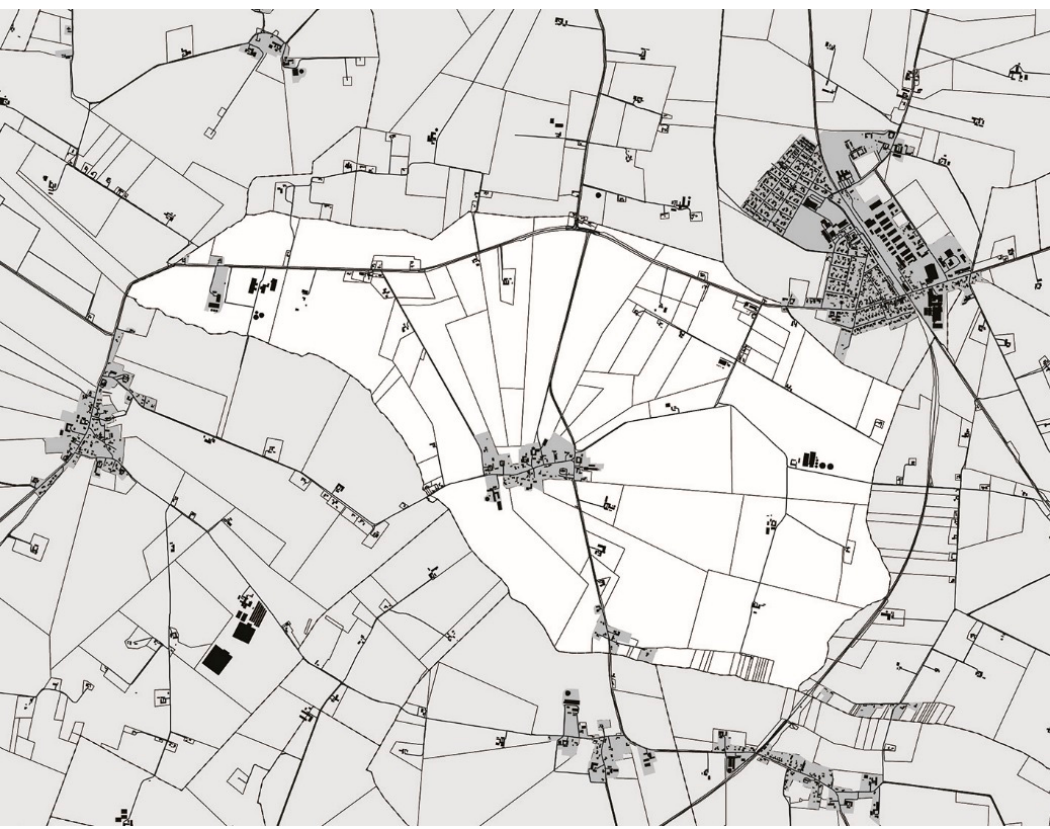
Figure 2. Map of Høve. The white area indicates the area of land belonging to the village. The village northwest of Høve is Dalmose, which grew as an effect of a former train station. The retail store and public school closest to Høve is situated in Dalmose.